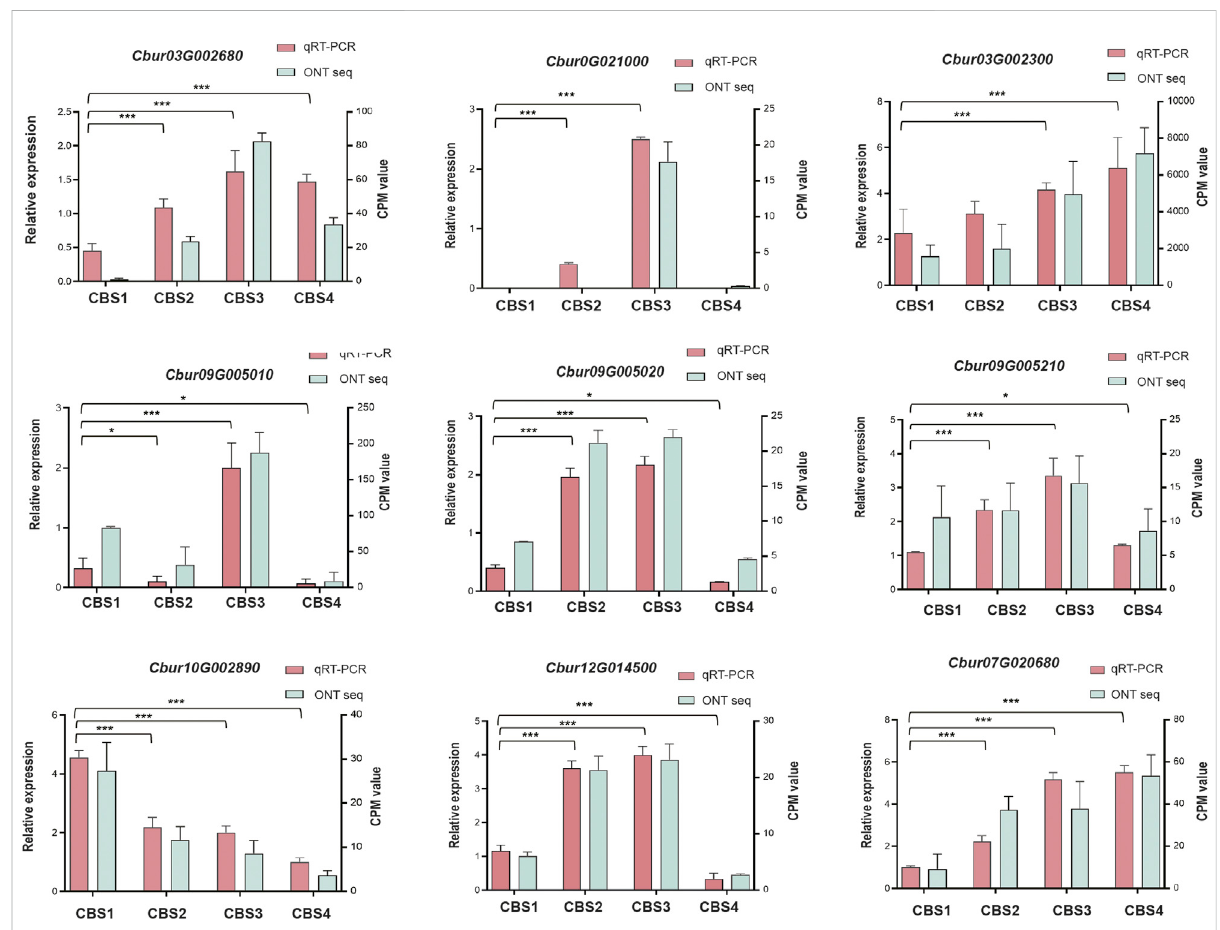
FIGURE 7 qRT-PCRvalidationoftheexpressionpatternsofnineselectedgenes.TheqRT-PCRwasperformed usingACTIN asan internal control.Counts per million (CPM) values of Nanopore sequencing data are indicated on the left y -axis, and the relative expression levels based on qRT-PCR are indicatedontheright y -axis.Symbol*and***indicatesthe p values < 0.05andvalues < 0.01usingone-way analysis ofvariance(ANOVA)andpaired t -test analysis,